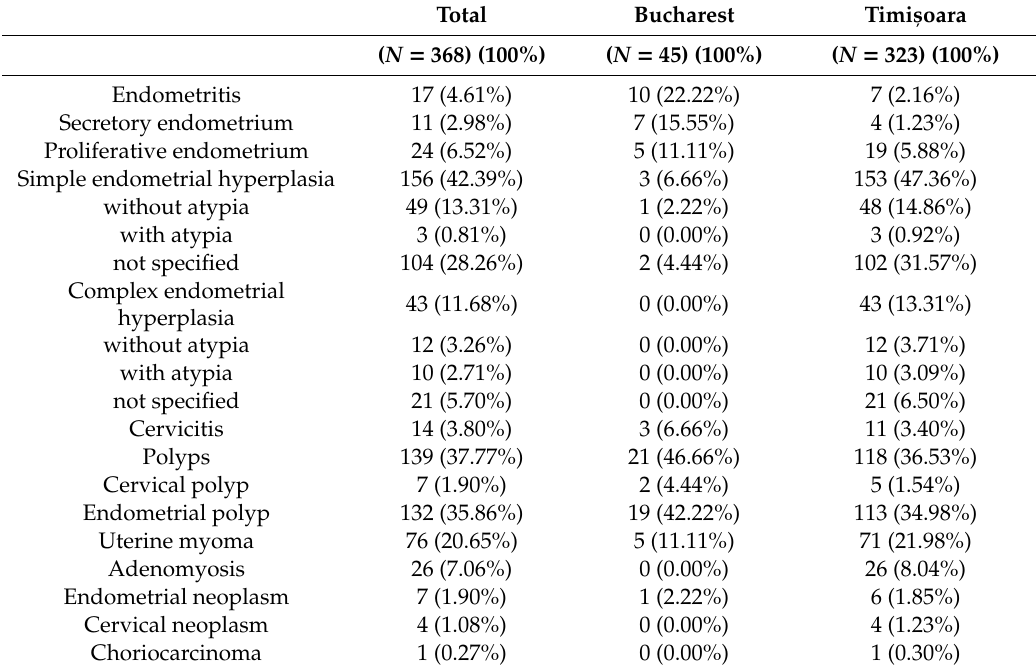
Table 5. Histopathological diagnoses by hospital (number of